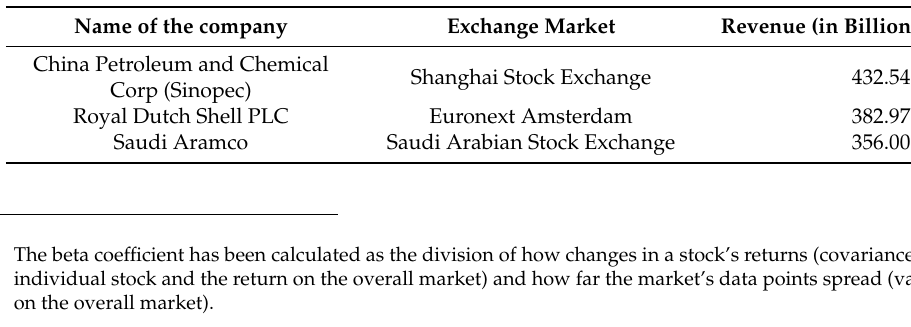
Table 1. Companies and data